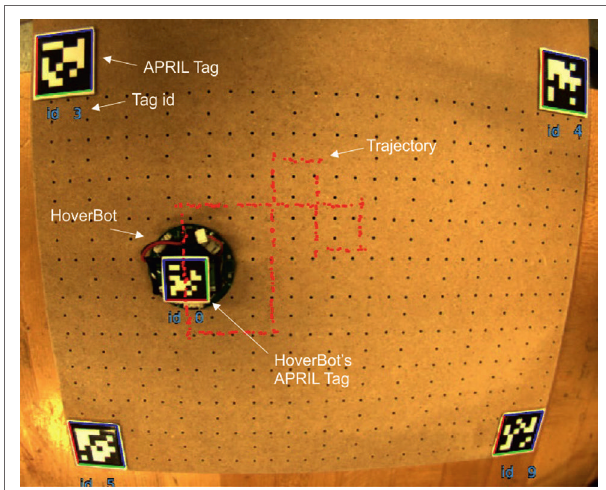
FigUre 5 | Experimental setup to evaluate a HoverBot’s locomotion performance. We placed one AprilTag in each corner of the levitation–magnet table. These tags serve as reference points and allow determination of a HoverBot’s relative position over time. Each AprilTag corresponds to an ID number. During experiments, we read out each AprilTag’s ID, x-position, y-position, and rotation. The red line indicates a HoverBot’s trajectory, which reinforces with each